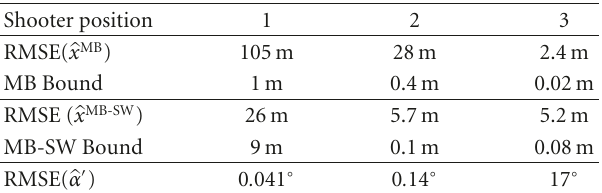
Table 4: Localization RMSE and theoretical bound (34) for the three di ff erent shooter positions using the MB and the MB-SW models, respectively, beside the aim RMSE for the MB-SW